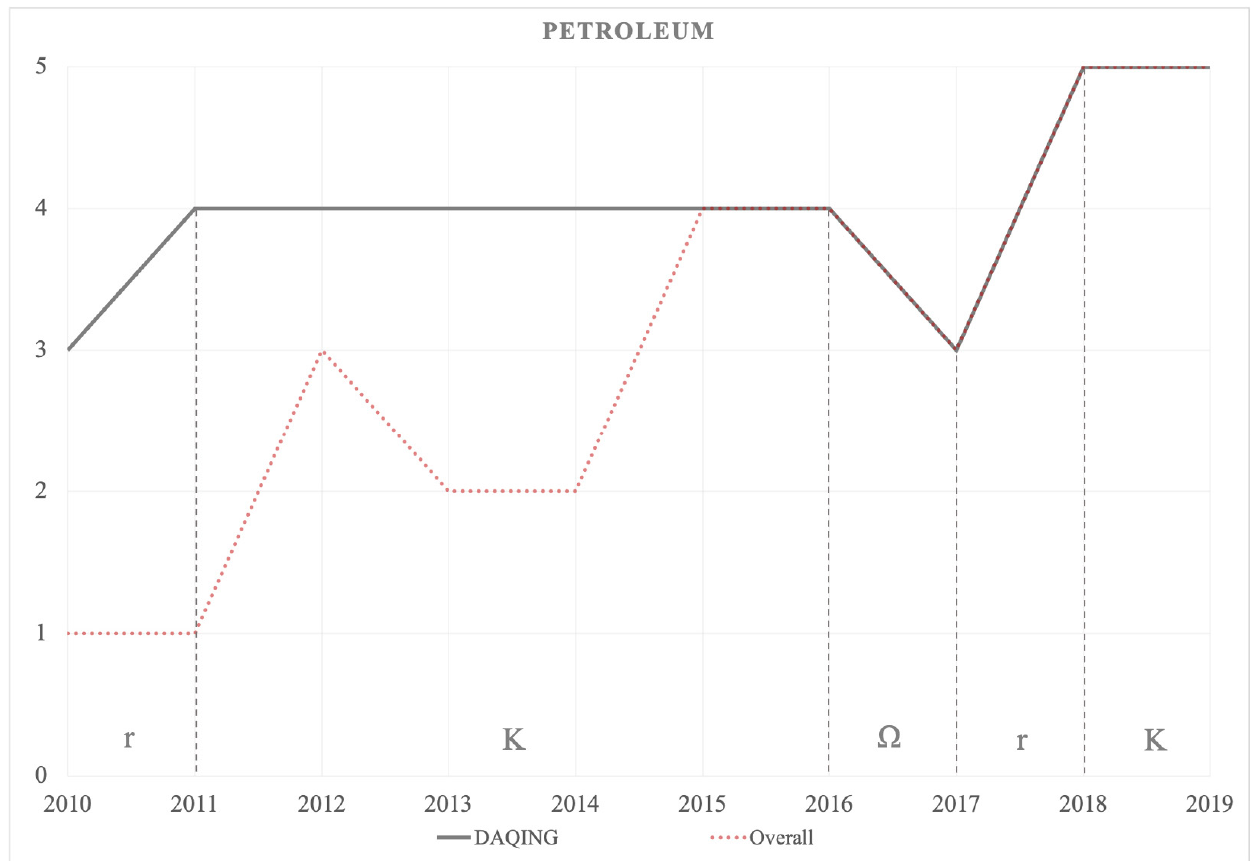
Figure 9. Resilience dynamics of petroleum-based cities from 2010 to 2019.